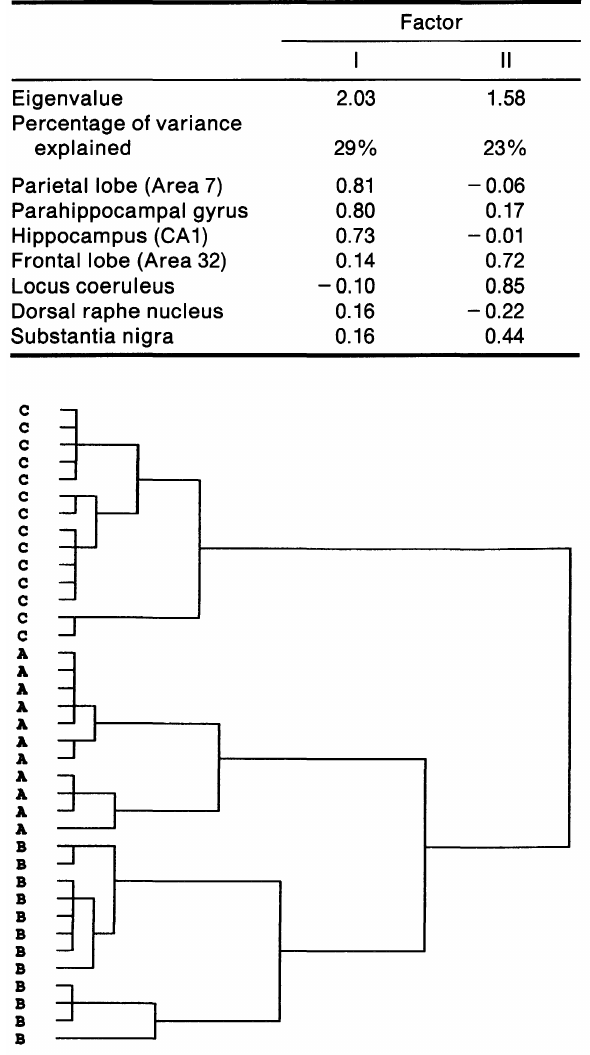
FIG. 1. Dendrogram demonstrating the hierarchical cluster structure based on cortical and subcortical neuron counts (A, Band C indicate cluster membership referring to Table